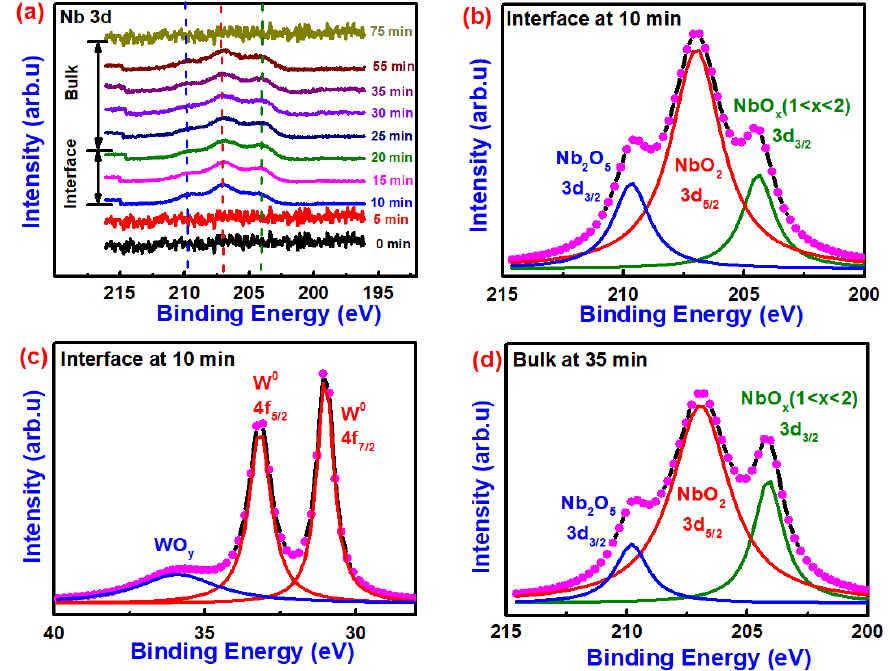
Figure 3. XPS Depth Profiling spectra of Nb and W elements in W / NbO x / Pt. ( a ) Nb 3d at di ff erent etch times. Fitted results of ( b ) Nb and ( c ) W spectra at 10 min etch time which shows the formation of WO y -NbO x interfacial bilayer. ( d ) Fitted results of Nb spectra at 35 min etch time show the coexistence of various oxides of niobium in the bulk.